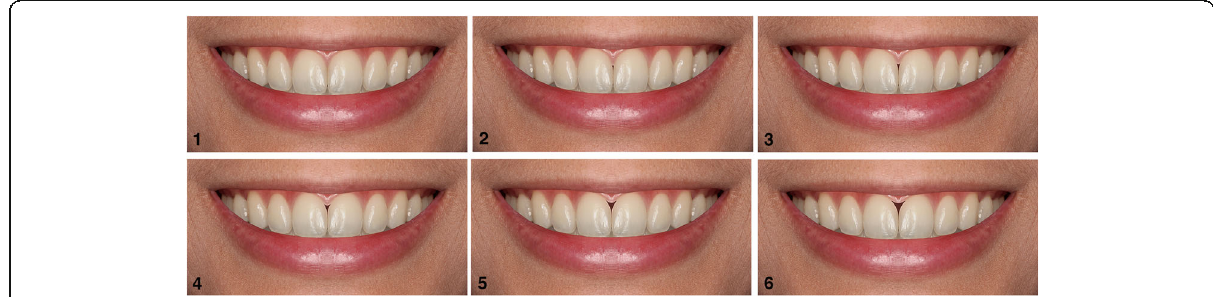
Fig. 3 Altered black triangles between the maxillary central incisors in 0.5-increments. 1 no black triangle; 2 0.5 mm; 3 1.0 mm; 4 1.5 mm; 5 2.0 mm; and 6 2.5